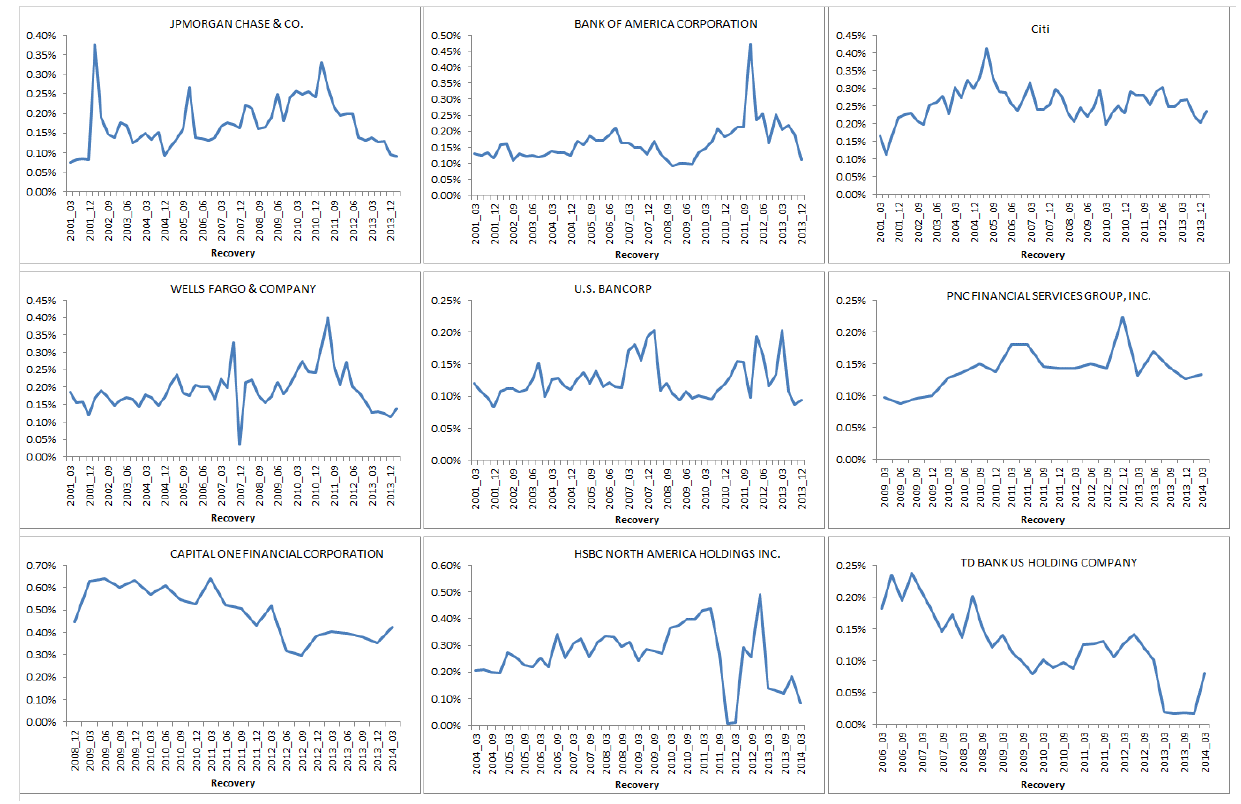
Figure 1. Relations of recoveries to the total value of the portfolio. Source: Author’s work.